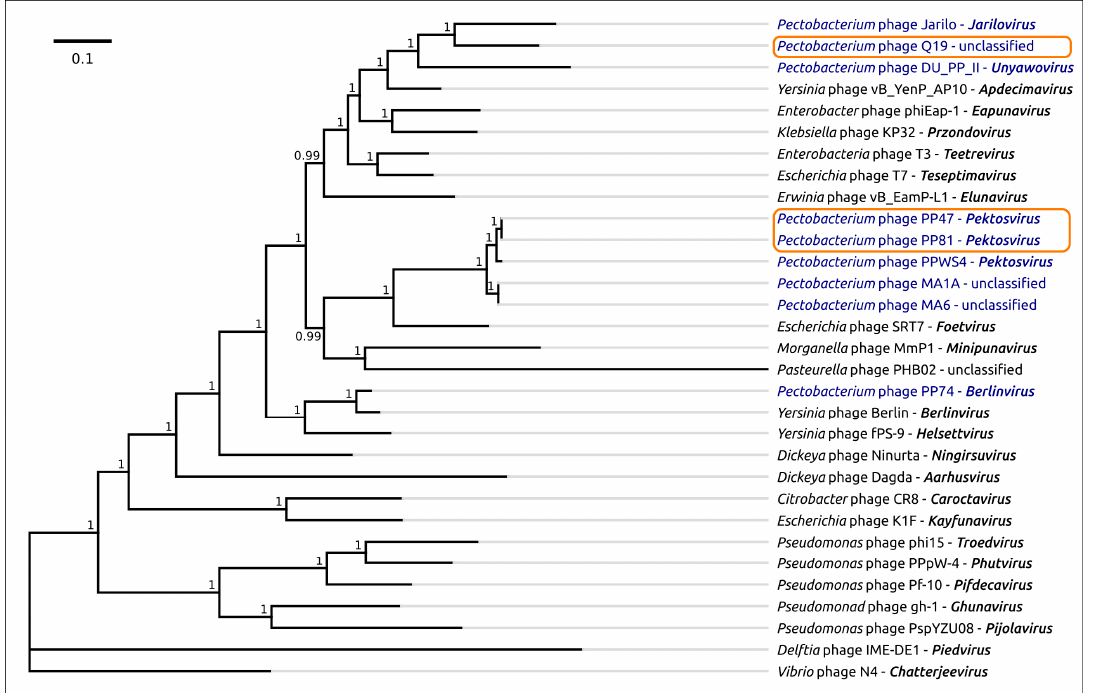
Figure 5. Phylogenetic tree obtained with MrBayes, based on concatenated sequences of DNA polymerase, a large subunit of terminase, a head-tail connector protein, a major capsid protein and a single-strand DNA binding protein extracted from the genomes of 29 phages, recognised by International Committee on Taxonomy of Viruses (ICTV) as master species belonging to the Studiervirinae subfamily, Pectobacterium phage PP74 of the Berlinvirus genus and Delphia phage IME-DE1. Bayesian posterior probabilities are indicated above their branch. Taxonomic classification is taken from ICTV and is shown to the right of the organism name. The scale bar shows 0.1 estimated substitutions per site and the tree was rooted to Delphia phage IME-DE1; of 2,000,000 generations, every 200 generations were sampled, with an average standard deviation of split frequencies of 0.0027.